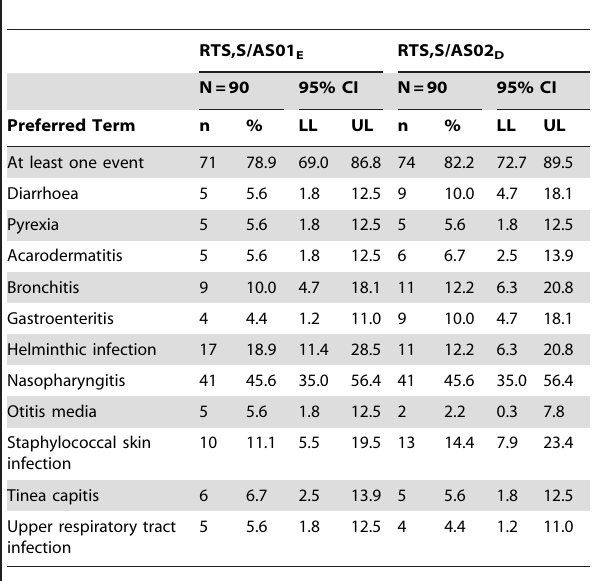
Table 3. Occurrence of unsolicited symptoms within the 30- day (Days 0–29) post-vaccination period.